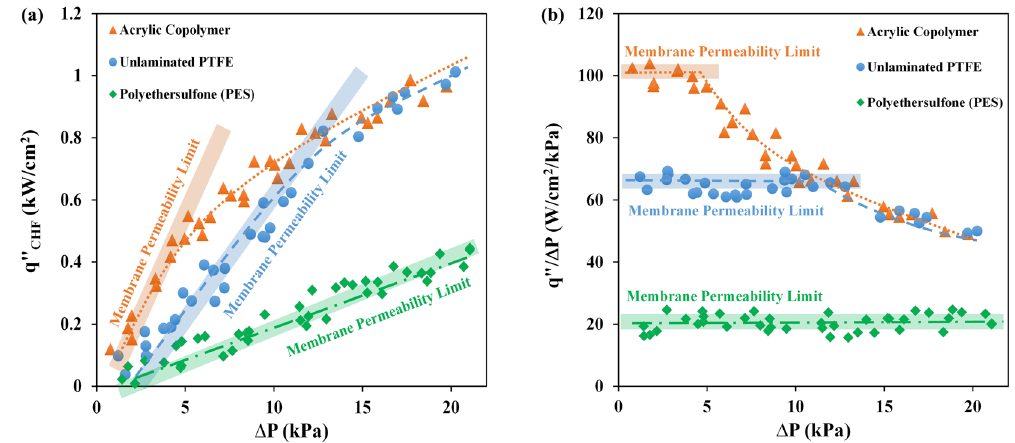
Figure 3. CHF performance of structure #4 tested with three different membranes; ( a ) Effect of membrane permeability on CHF and ( b ) CHF divided by liquid pool pressure as a function of liquid